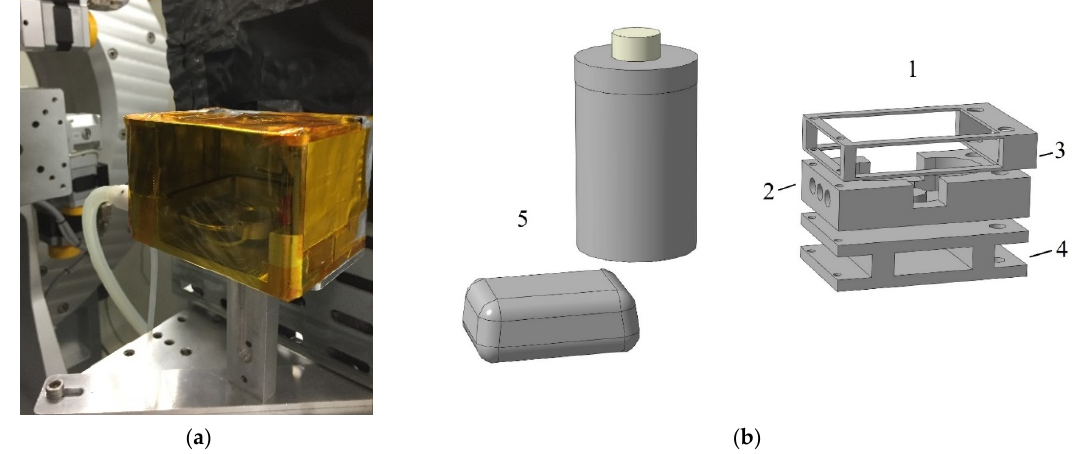
Figure 2. ( a ): Environmental cell for in-situ control of the atmosphere and temperature installed at BM26 beamline of ESRF; ( b ): schematics of the environmental cell components: (1)-sealed chamber, composed of a heating element (2), lid (3) to create controlled atmosphere around the sample, frame (4) for mounting, temperature and humidity control system. The latter consists of a dewar with liquid nitrogen (depicted as a cylinder) and a control panel/computer (depicted as a box) (5).